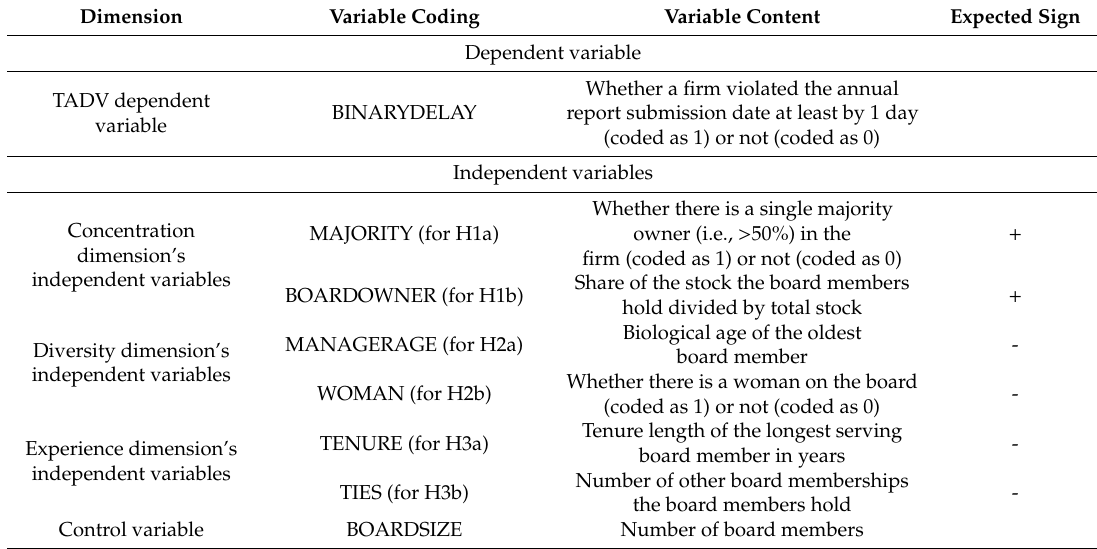
Table 1. Variables in the